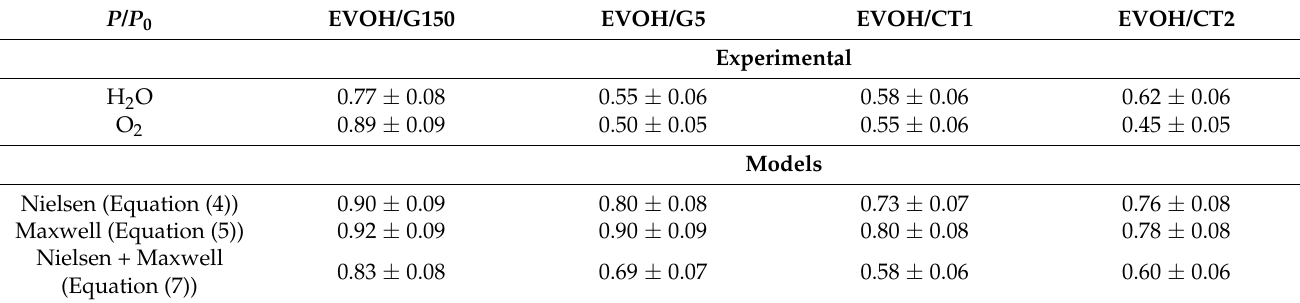
Table 4. Modeling of the relative permeability of the nanocomposites containing 2 wt% of filler ( a w = 0.95, T = 25 ◦ C). P / P